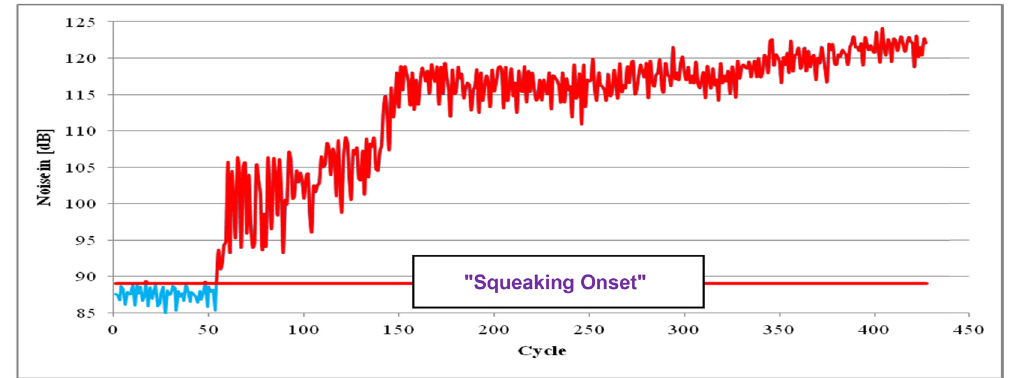
Figure 6: Noise level chart of the dry condition test ( blue is a background noise, and red is noise signal after squeaking occurrence )